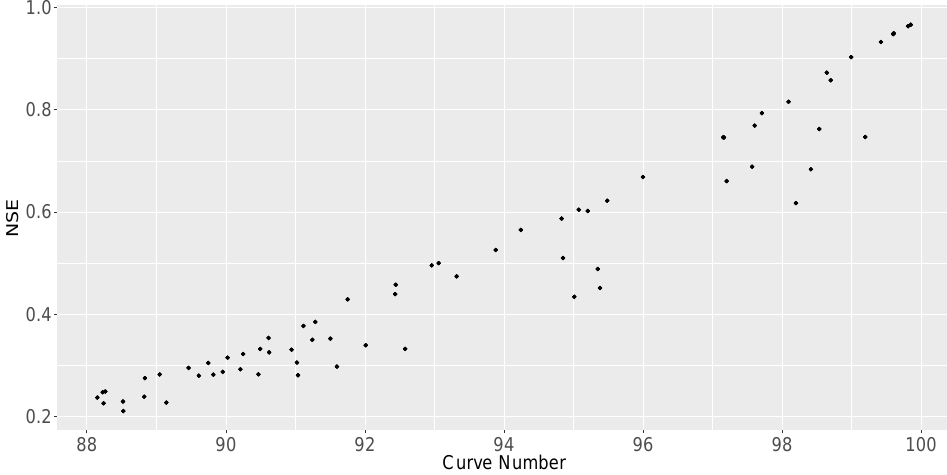
Figure 9. Computed NSE values for a continuous event.